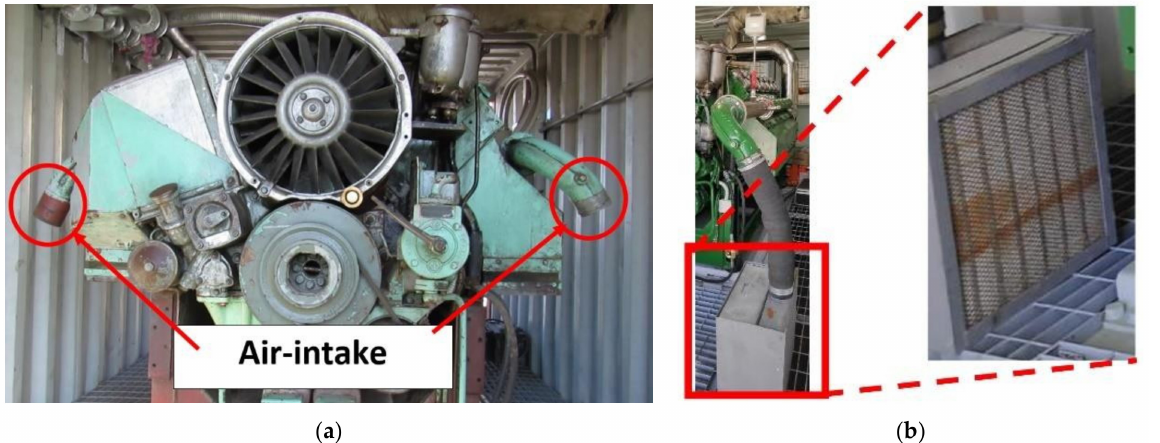
Figure 3. Air intake manifolds prior and after modification: ( a ) prior to the modification, indicating the absence of filters and space to install the required equipment and instruments; ( b ) after modifica- tion, indicating the installed air filters and the extended intake pipe on the right manifold to allow the installation of the thermal mass flow meter to record the intake air